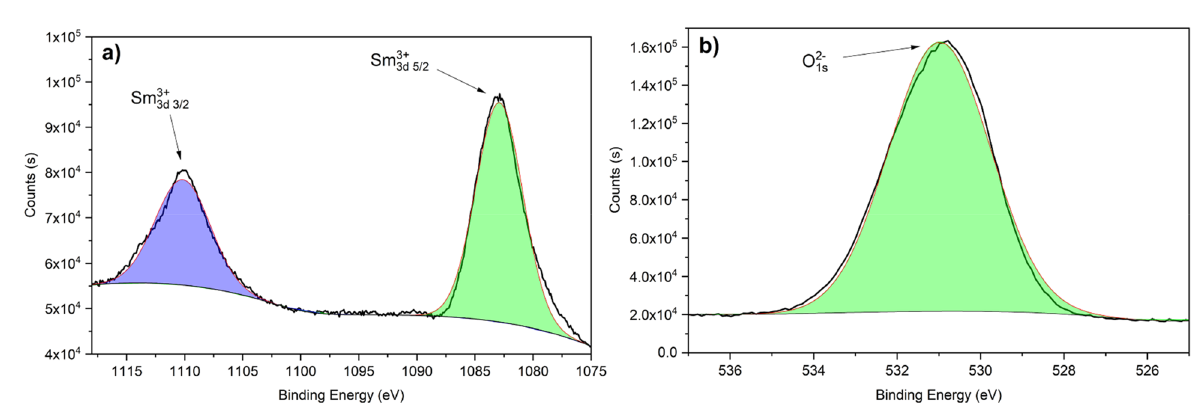
Figure 3. High-resolution XPS spectra of a samarium coating by immersion method corresponding to ( a ) Sm3d and ( b ) O1s.